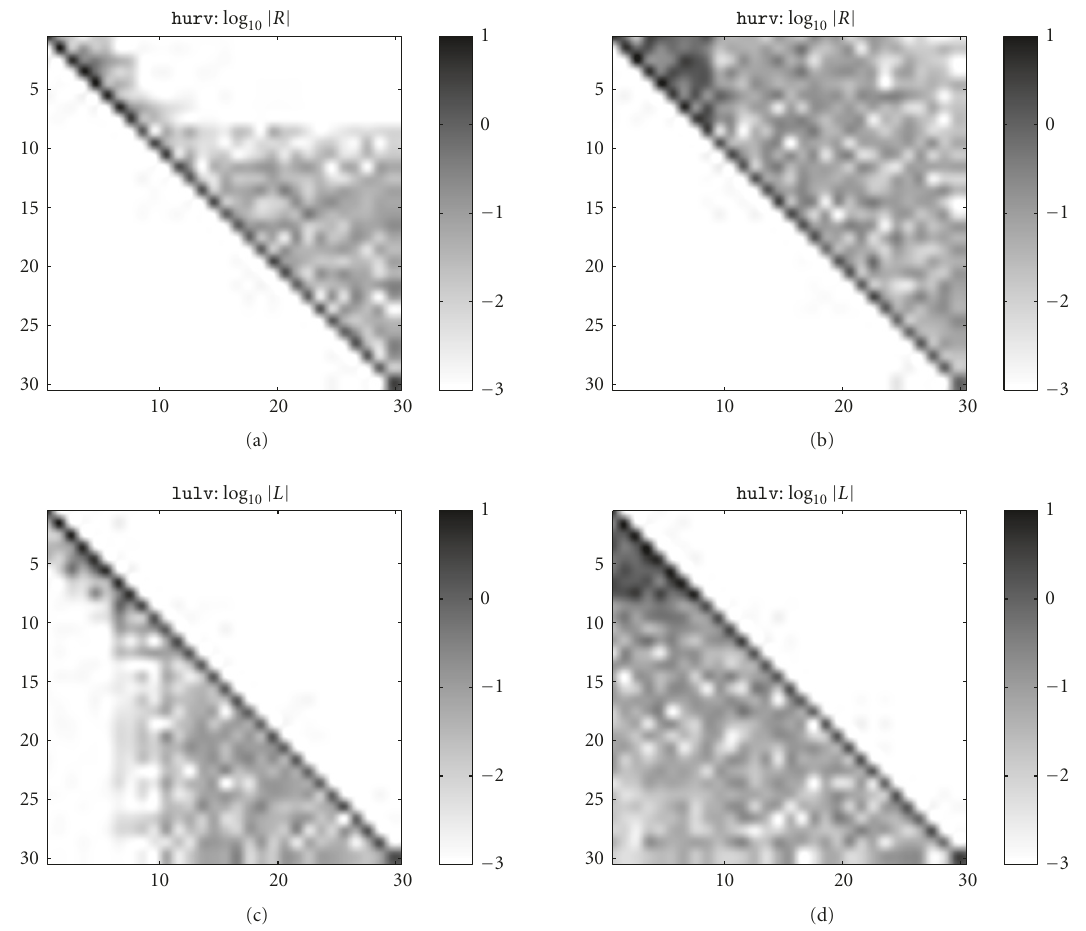
Figure 4: The large and small singular values are reflected in the size of the elements in the matrices R and L from the URV and ULV decompositions. The triangular matrices from the lurv and lulv algorithms (left plots) are closer to block diagonal form than those from the hurv and hulv algorithms (right